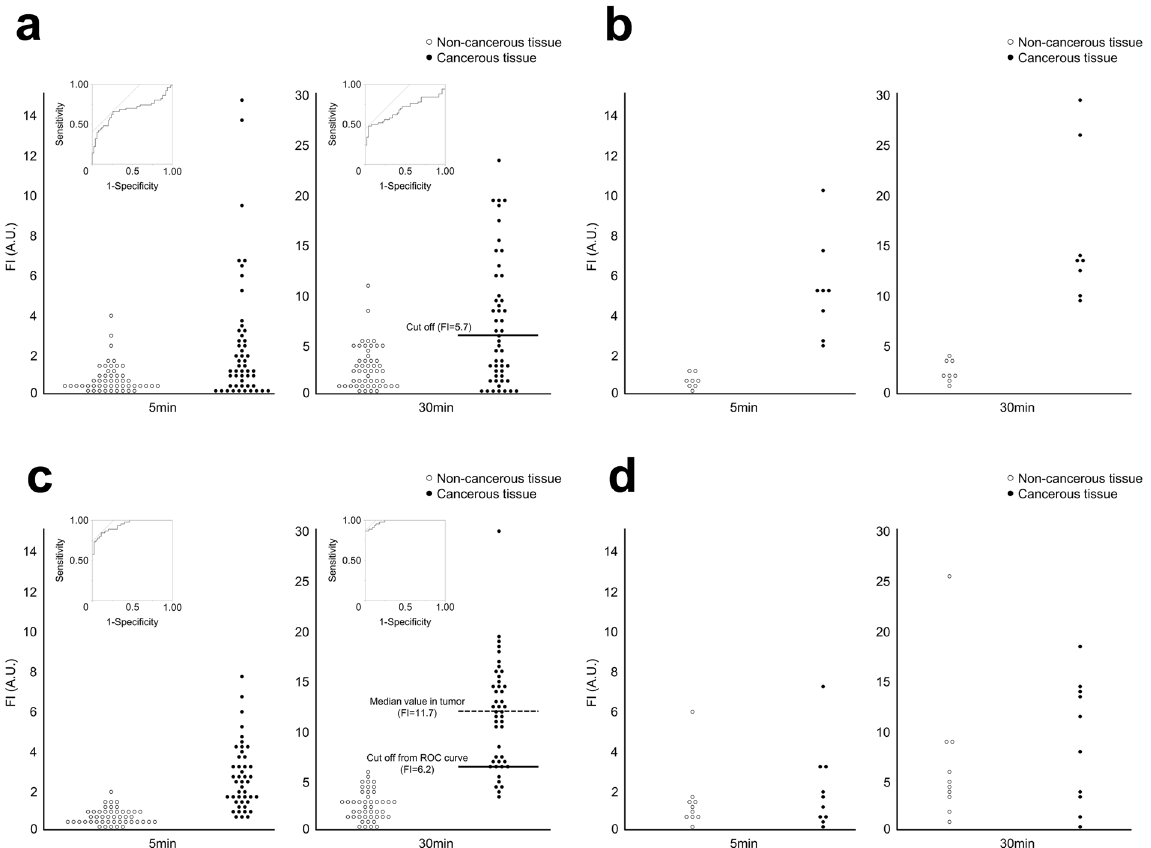
Figure 3. Sensitivity and specificity of gGlu-HMRG fluorescence imaging for detection of cancerous tissues. Scatter plots of the fluorescence intensities (FIs, in AU) of cancerous tissue and non-cancerous background tissues measured 5 and 30 min after spraying of HCC ( a , n = 50), ICC ( b , n = 45), CRLM ( c , n = 8), and primary colorectal cancer (d, n = 10) with gGlu-HMRG. ROC curves were also indicated in HCC ( a ) and CRLM ( c ). The median FIs of primary colorectal cancer and non-cancerous colorectal tissues at 30 min were 9.6 A.U. and 4.5 A.U., respectively ( P = 0.496, d